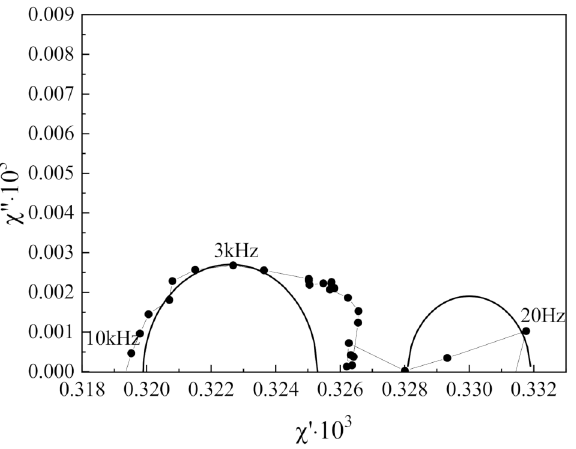
Figure 10. Argand diagram for the χ ”( χ (cid:48) ) dependence. Symbols are the experiment; semicircles are the calculation. The centers of the semicircles are at the points with the coordinates (0.3227; 0) and (0.331;